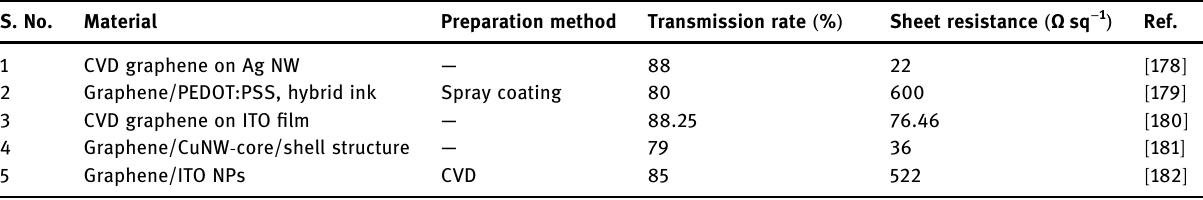
Table 3: Overview of the synthesis method and transparent conducting behavior of graphene - based nanocomposites S.